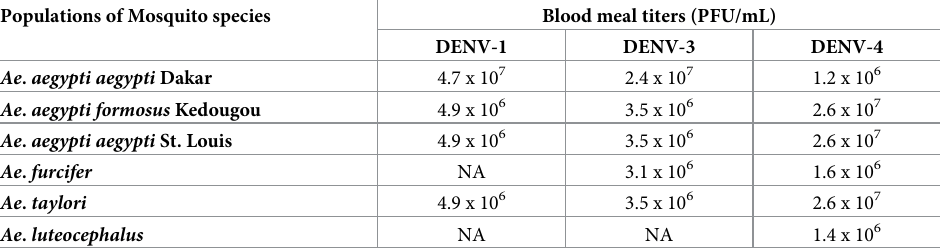
Table 4. Titers of the infectious blood meal after 1 hour of exposure to the different mosquito species.